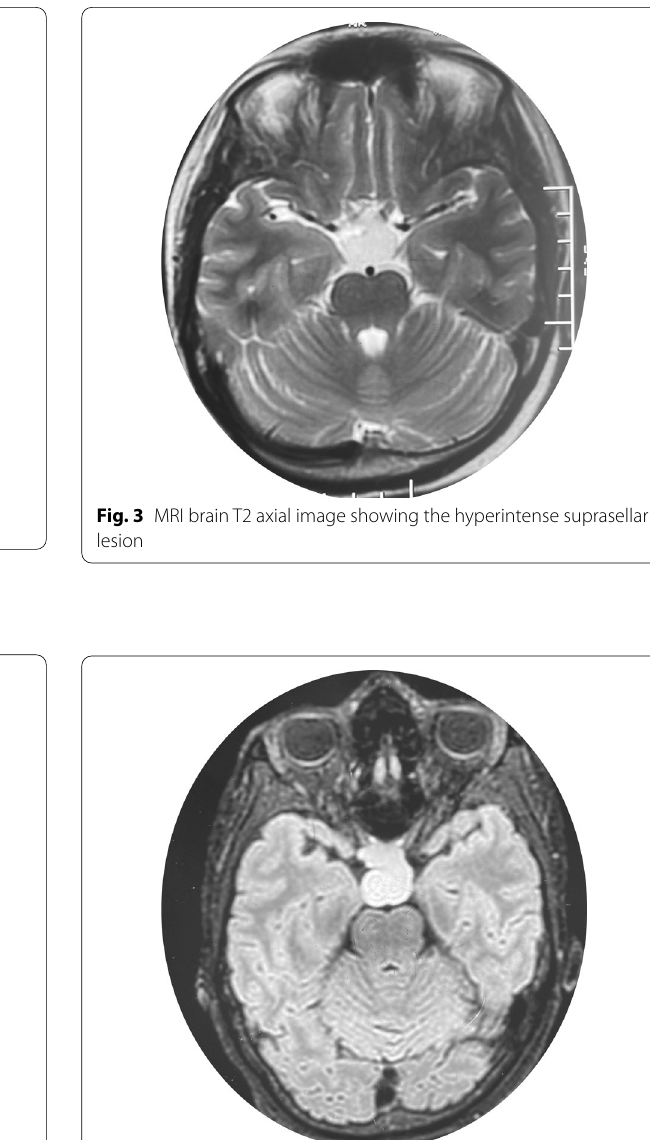
Fig. 2 MRI brain T1 axial image showing slightly hyperintense lesion in the suprasellar area